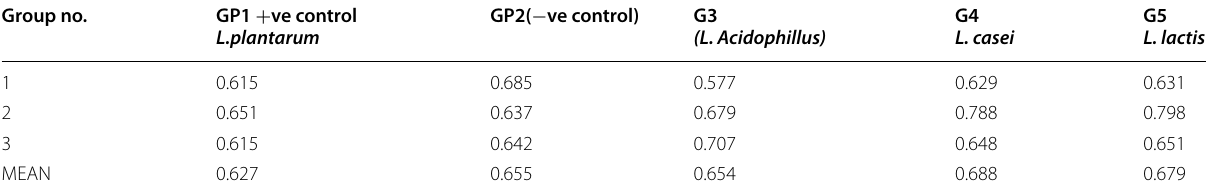
G3 (L. Acidophillus, G4 L. casei , G5 L. lactis , Gl (positive control, L . plantarum ), G2 (CONTROL, no bacteria)